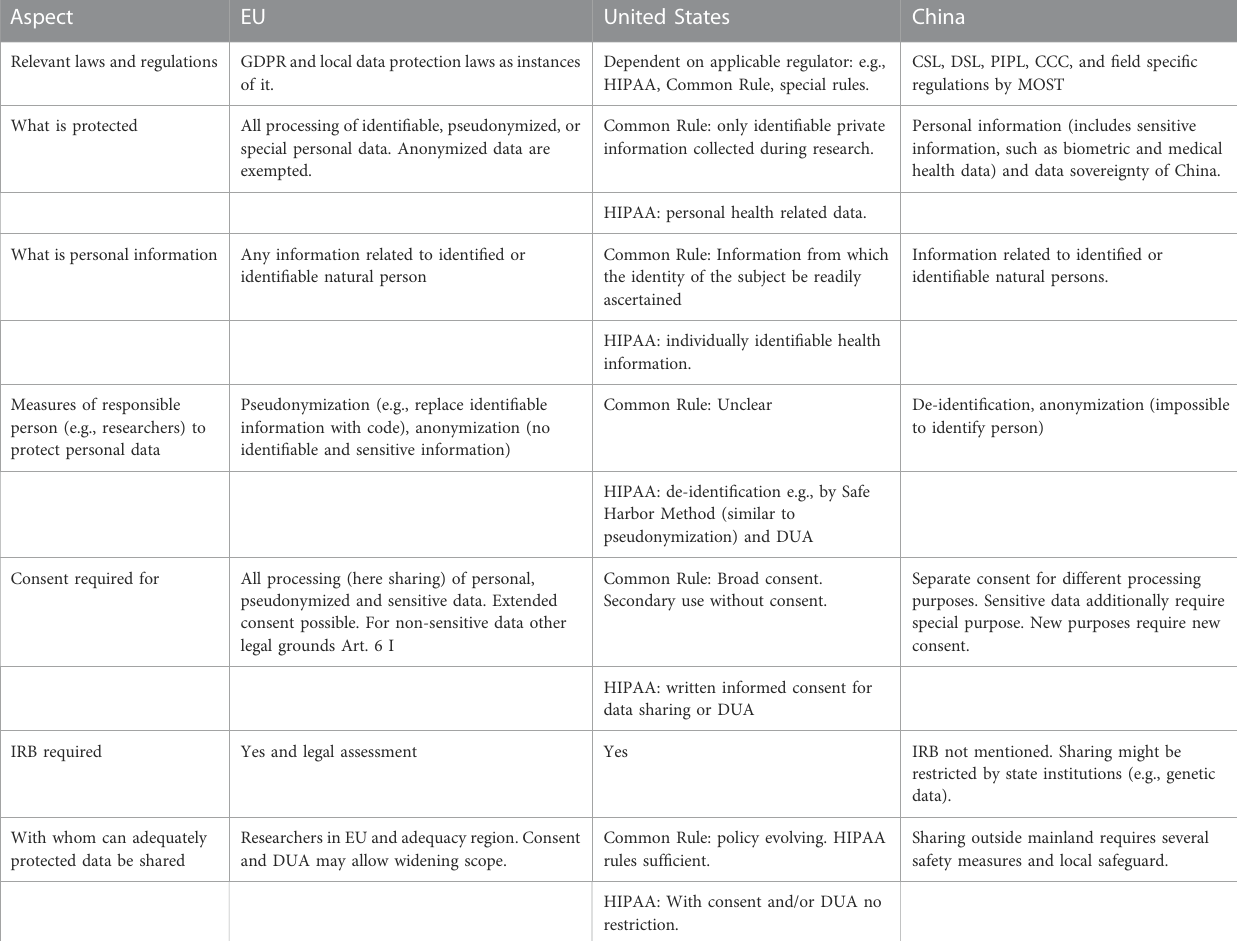
TABLE 1 Overview of data protection regulations for publicly funded research.